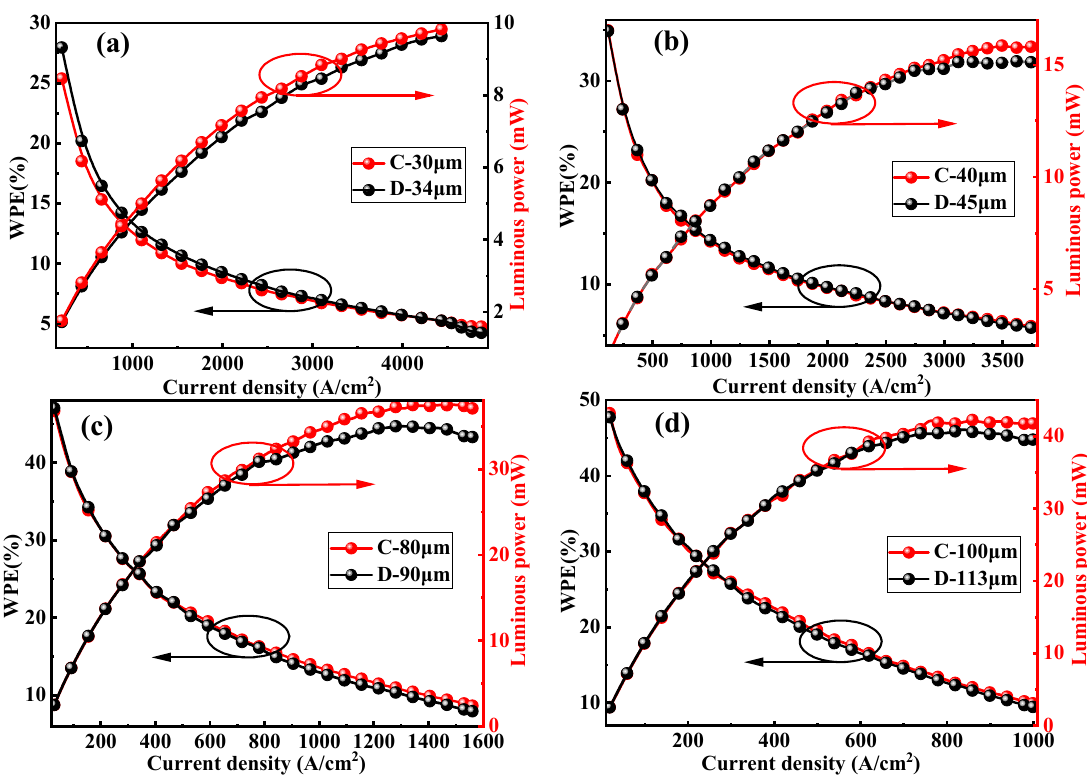
Figure 4. WPE and luminous power of C and D at different current densities, ( a )–( d ) correspond to experimental group I–IV (The size of the mesa increases gradually).